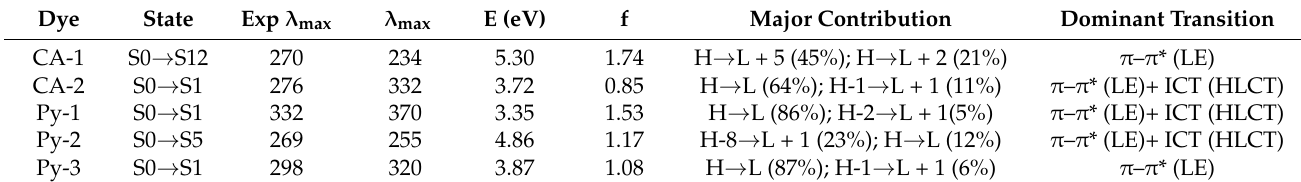
Figure 5. Experimental UV-Vis spectra of the synthesized dyes measured in DMF solvent. The experimental UV-Vis spectra (Figure 5) show that all dyes exhibit an absorption band covering the mid-UV/near-UV region (269–330 nm) of solar spectrum. The relative bathochromic shift of Py-1 dye is signifying the previously calculated lower energy gab between the frontier molecular orbitals due to boosted planarity and conjugation length. Additionally, a hyperchromic shift is observed for Py-1 dye which is attributable to the incorporation of fused thienothiophene heterocycle. Judicious choice of fused conjugation unit of Py-1 dye is expected to enhance the light-harvesting capability and ultimately the higher PCE. The calculated electronic absorptions (Table 2) agree with the experimental observations in reproducing the relative red-shifted λ max of Py-1 dye. Table 2. Experimental and calculated TD-DFT Excitation Energies (eV, nm), Oscillator Strengths (f), Compositions in Terms of Molecular Orbital Contributions, and Dominant Character of the